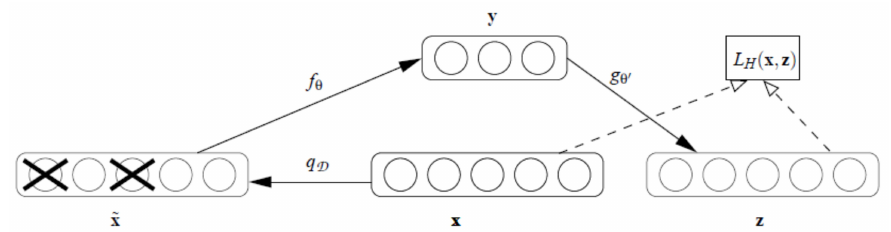
Figure 3. The structure of Denoising Autoencoder (the signal obtained by adding random noise to the original input x , f θ is the encoder, y is the intermediate proxy after encoding and mapping, g θ (cid:48) is the decoder, z is the reconstruction input, and L H ( x , z ) is the reconstruction loss, which is used to measure the reconstruction